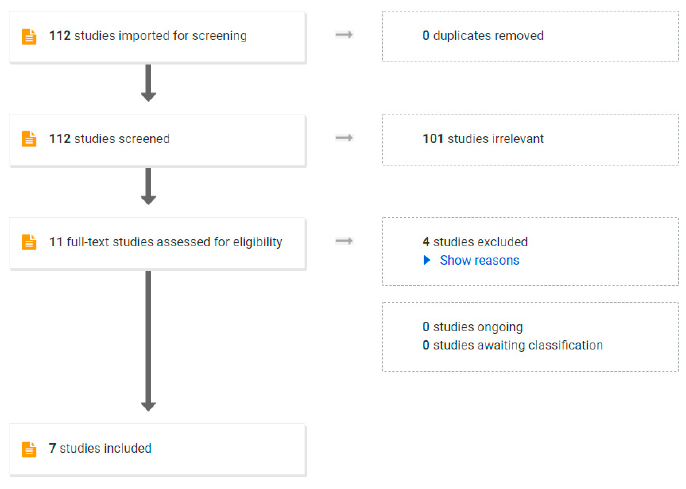
Figure 2. PRISMA Flow chart used in systematic review.